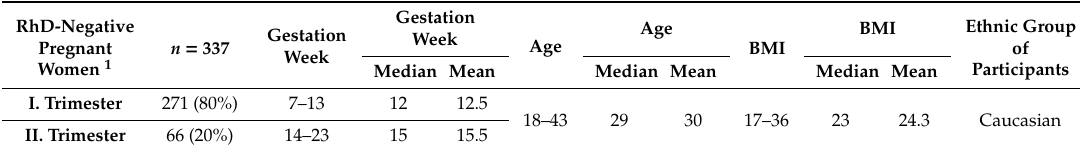
Table 1. Characterization of the sample